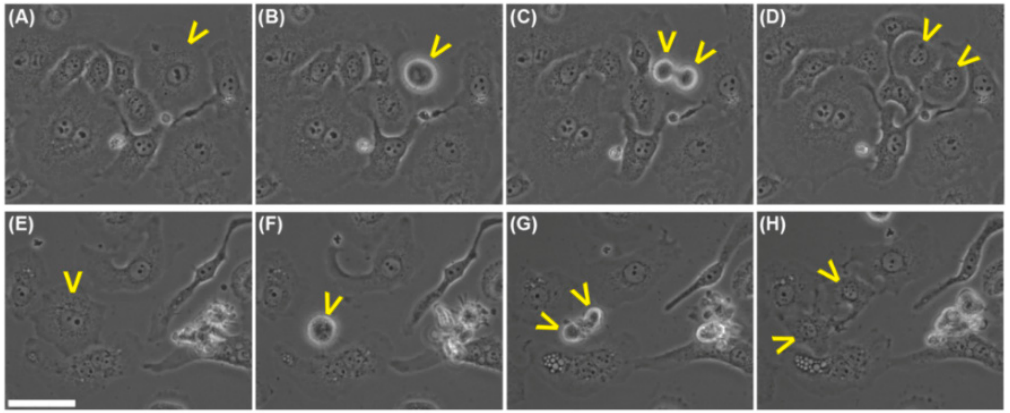
Figure 11. Phase contrast micrographs showing cells before, during and at the end of mitosis. Yellow arrowheads indicate cells of interest. ( A ) Control cells before starting any mitosis; ( B ) A control cell is rounding up starting its mitosis; ( C ) The same cell as in ( B ) 20 min later, during cytokinesis; ( D ) The two daughter cells, resulting in mitosis, significantly spread 1 h after mitosis was started; ( E ) Treated cells before starting any mitosis; ( F ) A treated cell rounded up and starting its mitosis; ( G ) The same cell as in ( F ), 200 min later, accomplishing its cytokinesis; ( H ) The daughter cells showing significant spreading 90 min later, that means almost 5 h after mitosis has started. White scale bar in ( E ) represents 50 μ m, and is identical for all the images.